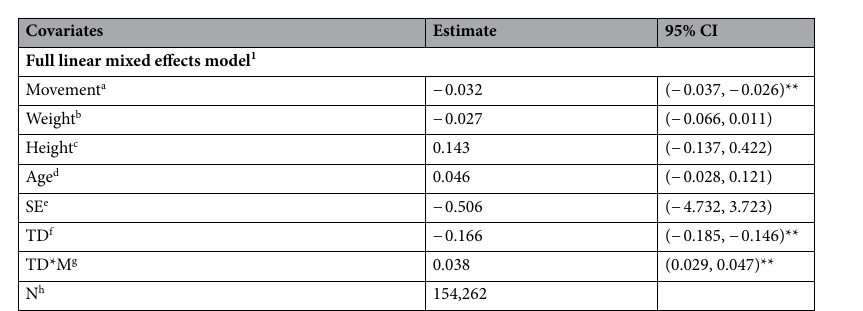
Covariates Estimate 95% CI Full linear mixed effects model 1 Table 4. Relationships of movement, weight, height, age, sleep efficiency, time of day and interaction term (movement & time of day) with glucose rate of change (%) in pregnancy (95% CI). Regression coefficients are given by the 1st quartile unit increases for movement, weight, height, age and sleep efficiency. The 1st quartiles for movement, weight, height, age and sleep efficiency are as follows: Movement = 1.6 mg. Weight = 66 kg. Height = 1.63 m. Age = 27.9 years. Sleep efficiency = 88%. 1 Full linear mixed effects model: a Movement ( mg ), b Weight (kg), c Height (m), d Age (years), e Sleep efficiency (%), f Time of day (2-level factor, sleeping period and waking period, as reference). g Interaction term of time of day and movement. h Number of observations. **Statistically significant results.